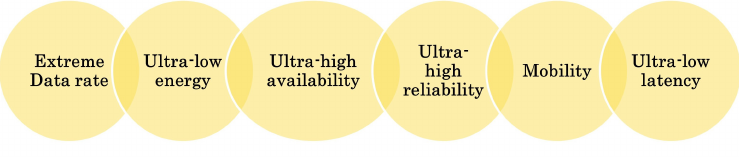
Figure 1. Main requirements of AR/VR